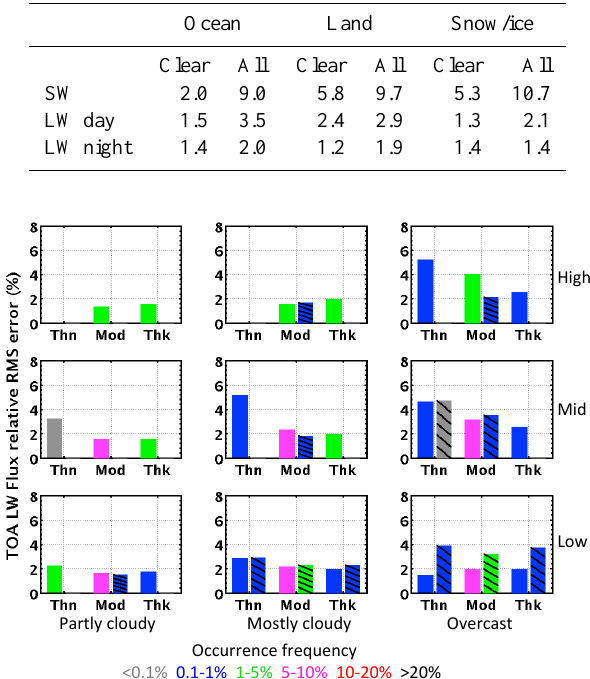
Figure 11. Same as Fig. 9, but over snow and